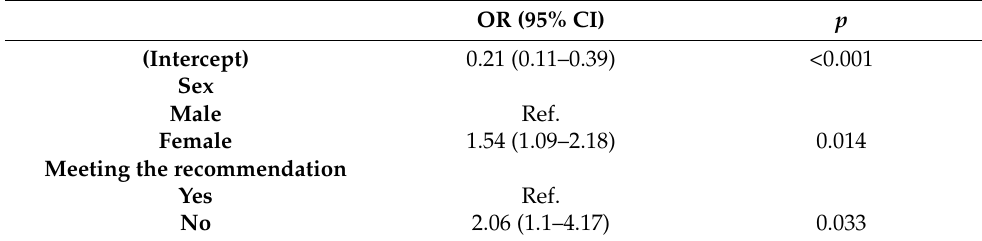
Table 3. Logistic regression model for recurrent